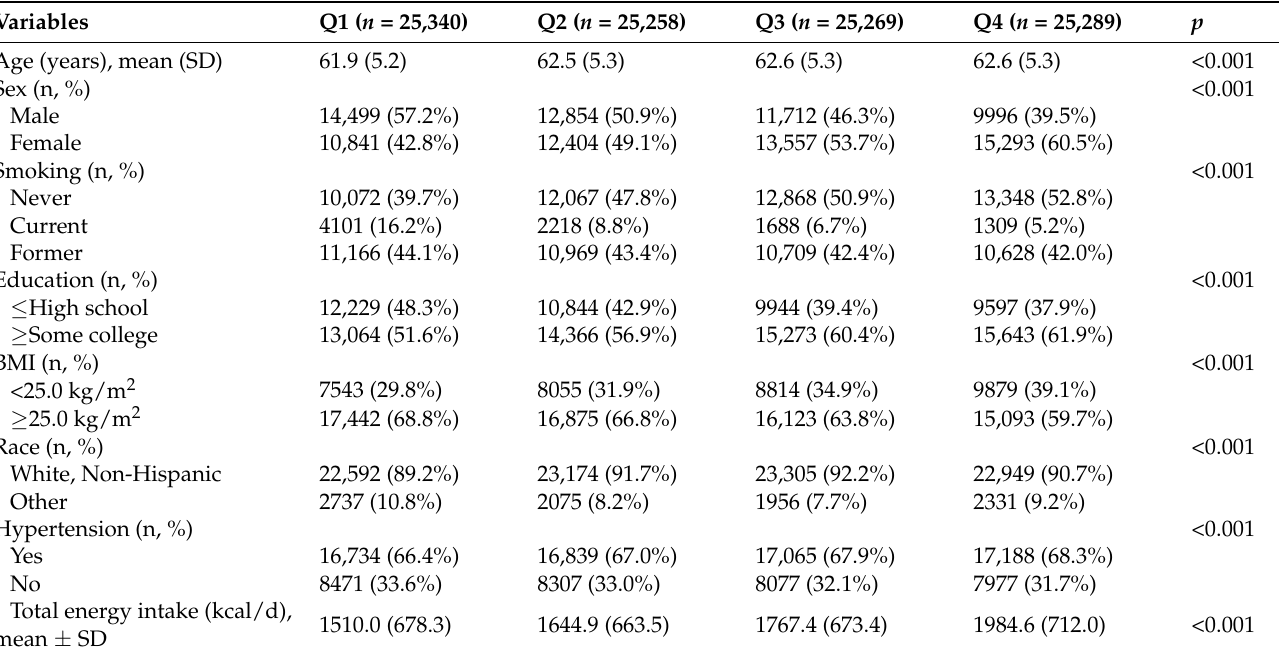
Table 1. Main characteristics of participants included in this study by dietary anthocyanidin intakes.